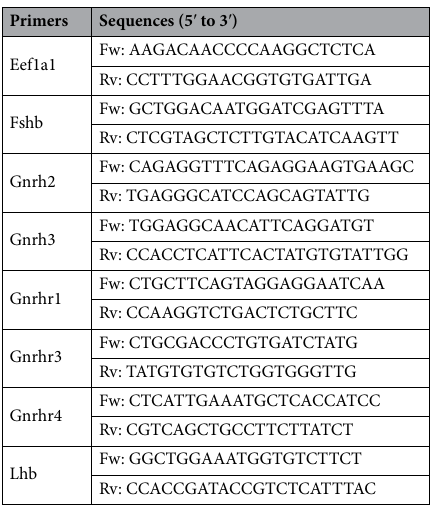
Table 1. Sequences of forward and reverse primers used in the qPCR